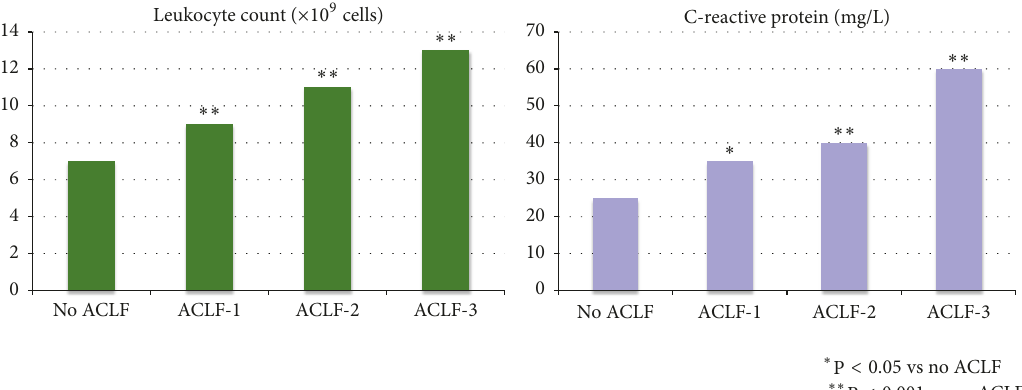
Figure 1: Proof of dysbalanced inflammatory response: relationship between the degree of inflammatory reaction, as estimated by the leukocyte count and C-reactive protein, and the severity of ACLF.